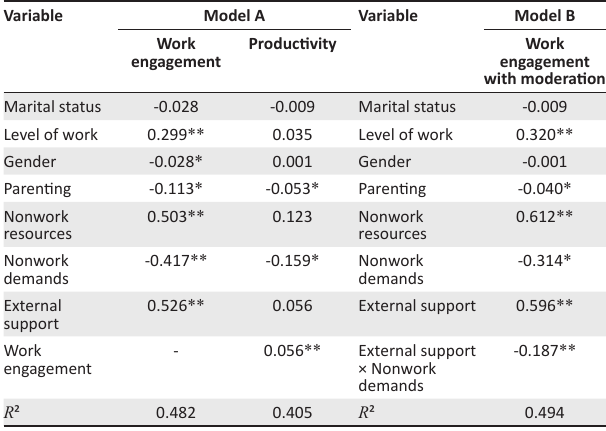
TABLE 1: Structural equation modelling